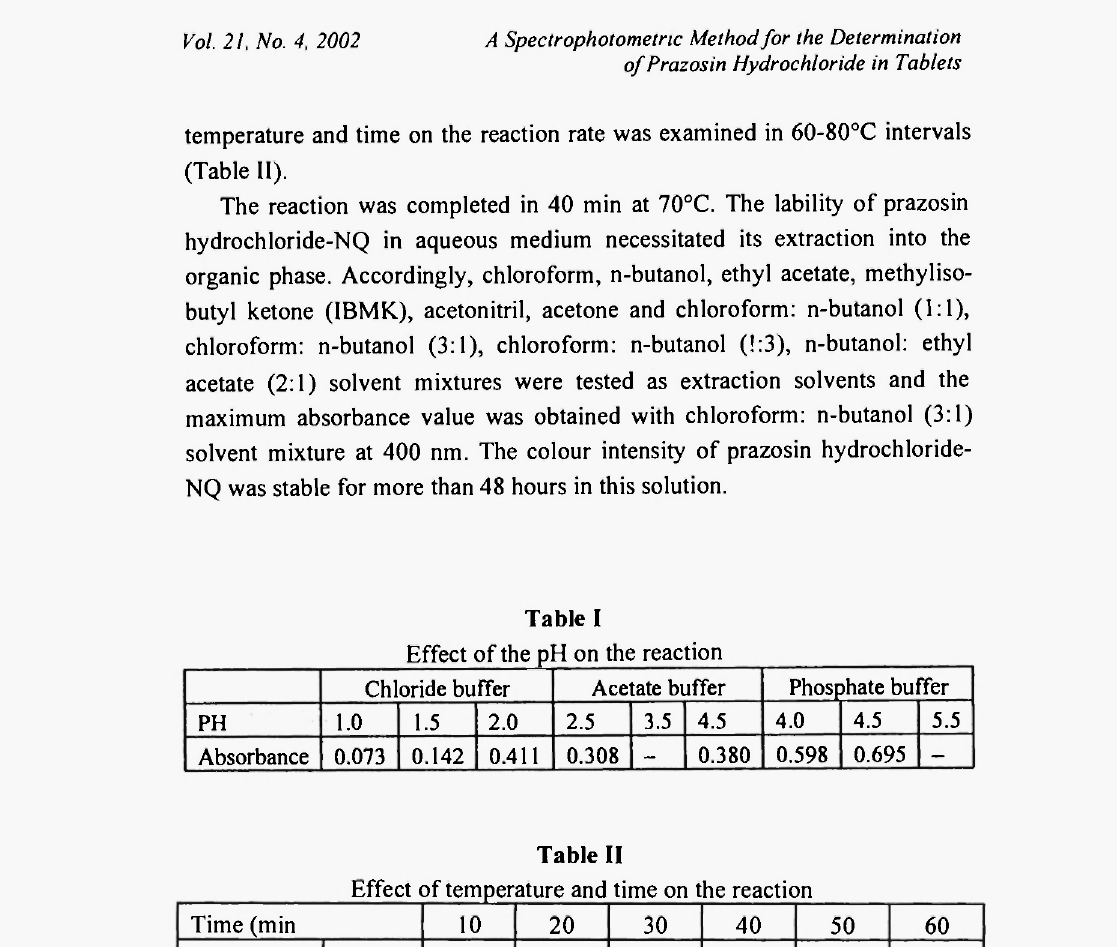
Effect of the pH on the